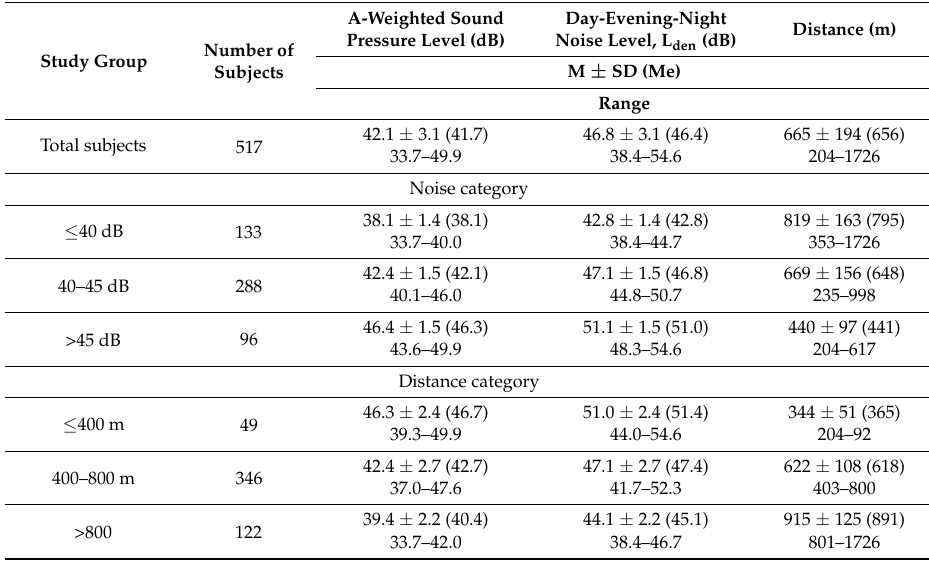
Table 4. Summary results of noise calculations for areas where the respondents lived, with a distance of their dwellings from the nearest wind turbine.